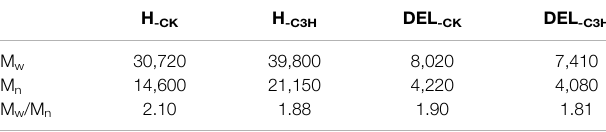
TABLE 3 | Weight-average (M w ) and number-average (M n ) molecular weights and polydispersity (M w /M n ) of the hemicelluloses and lignin fractions. H